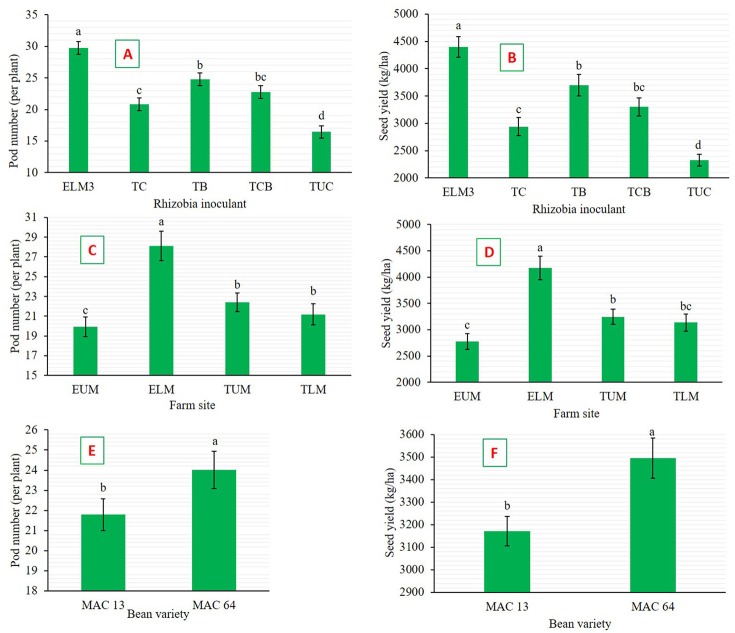
Effects of the main factors on climbing bean yield parameters in the field. (A) Effect of rhizobia inoculation on pod number. (B) Effect of rhizobia inoculation on seed yield. (C) Effect of farm site on pod number. (D) Effect of farm site on seed yield. (E) Effect of bean variety on pod number. (F) Effect of bean variety on seed yield. Bars followed by the same letter are not significantly different according to Tukey's HSD test at P ≤ 0.05. ELM3, Test native rhizobia isolate; TC, Consortium of native rhizobia; TB, Commercial inoculant (Biofix); TCB, Biofix combined with consortium; TUC, Negative control (Non-inoculated); ELM, Embu Lower Midland; EUM, Embu Upper Midland; TLM, Tharaka Nithi Lower Midland; TUM, Tharaka Nithi Upper Midland.